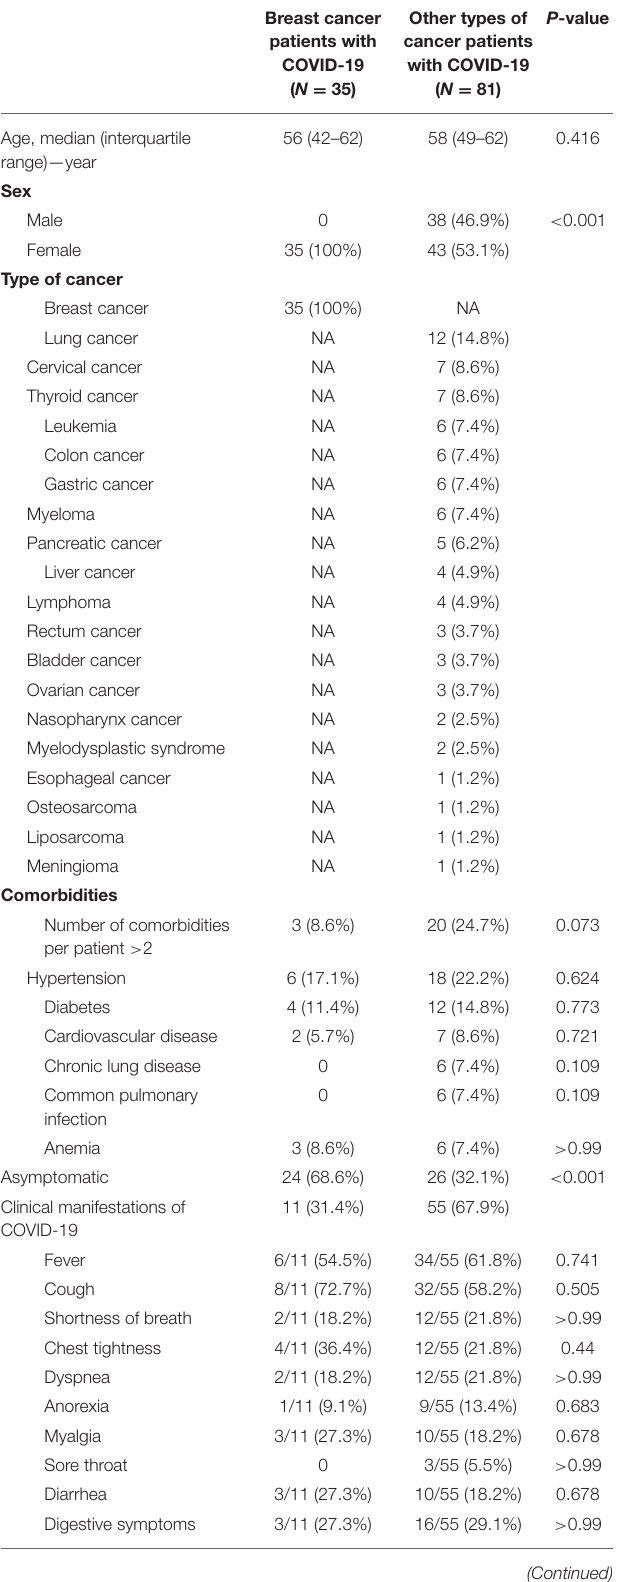
TABLE 6 | Comparison of clinical characteristics between breast cancer patients with COVID-19 and other types of cancer patients with COVID-19. Breast cancer patients